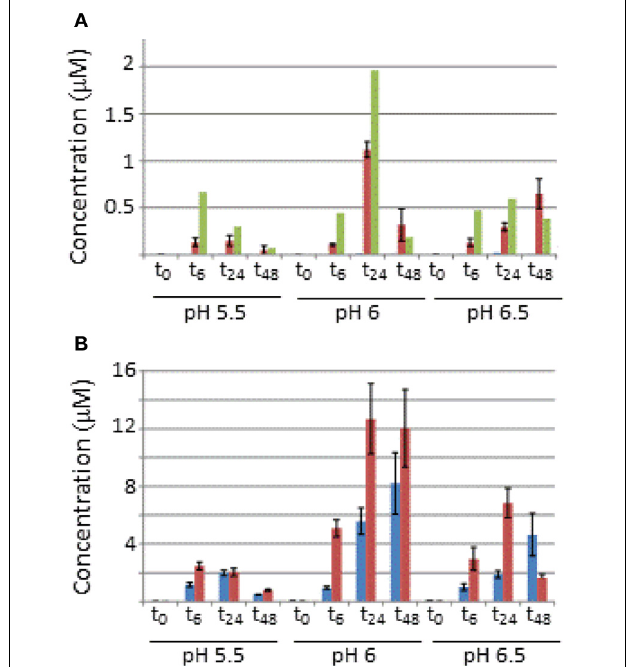
FIGURE 2 | Absolute concentrations of AvrPto1 (A) and HrpA1 (B) in the pellet and extracellular fractions after 0, 6, 14, and 48 ( t 0 – t 48 ) after induction in HIM-fructose media at different pH (as indicated). Concentrations from cell (blue) and extracellular fractions (red) are in μ M and in the case for AvrPto1, concentrations were also normalized against OD 600 (green bars) of the cultures. Judged by OD 600 growth was very similar between cultures, reaching OD 600 values of 1.7, except for t 48 in the case of pH 5.5, which only grew up to 0.64. Error bars represent one standard deviation from the mean from the four averaged transitions of AvrPto1 and the two available transitions of HrpA1 (see